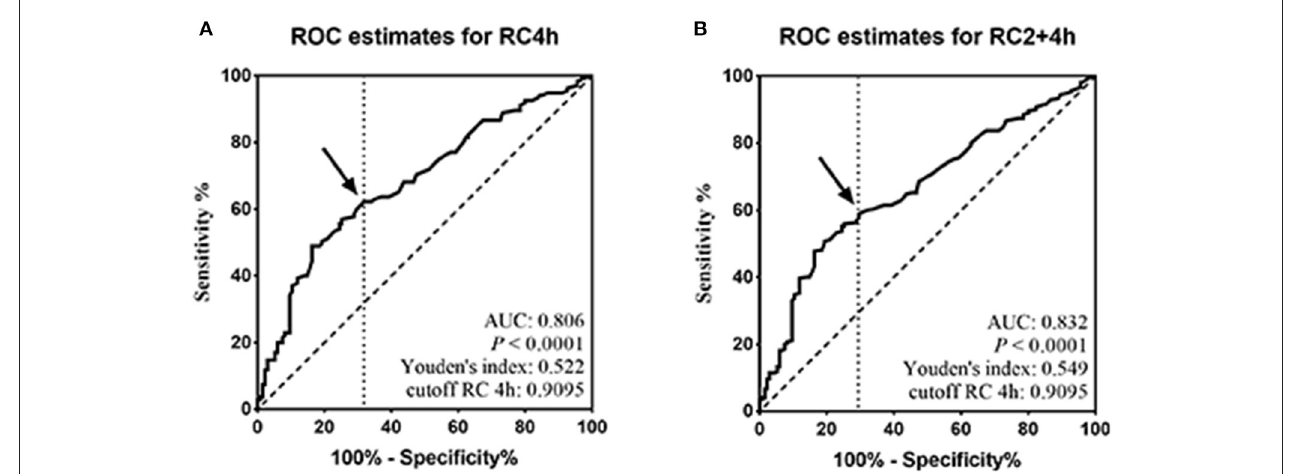
FIGURE 2 | Determination of the postprandial optimal cutoff point corresponding to fasting high RC. (A,B) ROC analysis and Youden index determined a cutoff point for postprandial HRC at 4h (pRC4h) or at both 2 and 4h (pRC2 + 4h) after a daily meal; the cutoff point was indicated by the solid arrow.